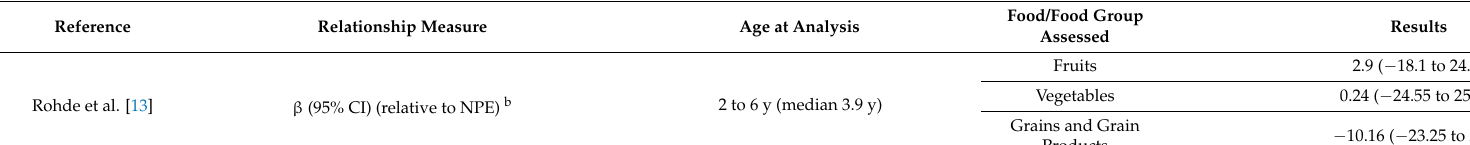
Table 4. Food Preferences Assessed as a Function of PE Status a